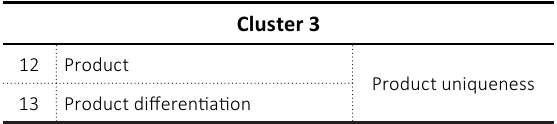
Table 4. Codes comprising Cluster 3